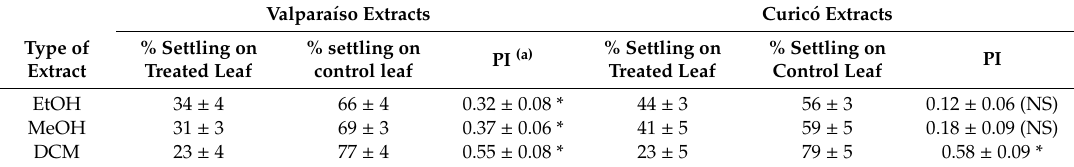
Table 5. Anti-settling activity (a) on Macrosiphum euphorbiae of the di ff erent extracts ( N = 10 replicate / extract; 20 aphids / replicate). Valpara í so Extracts Curic ó